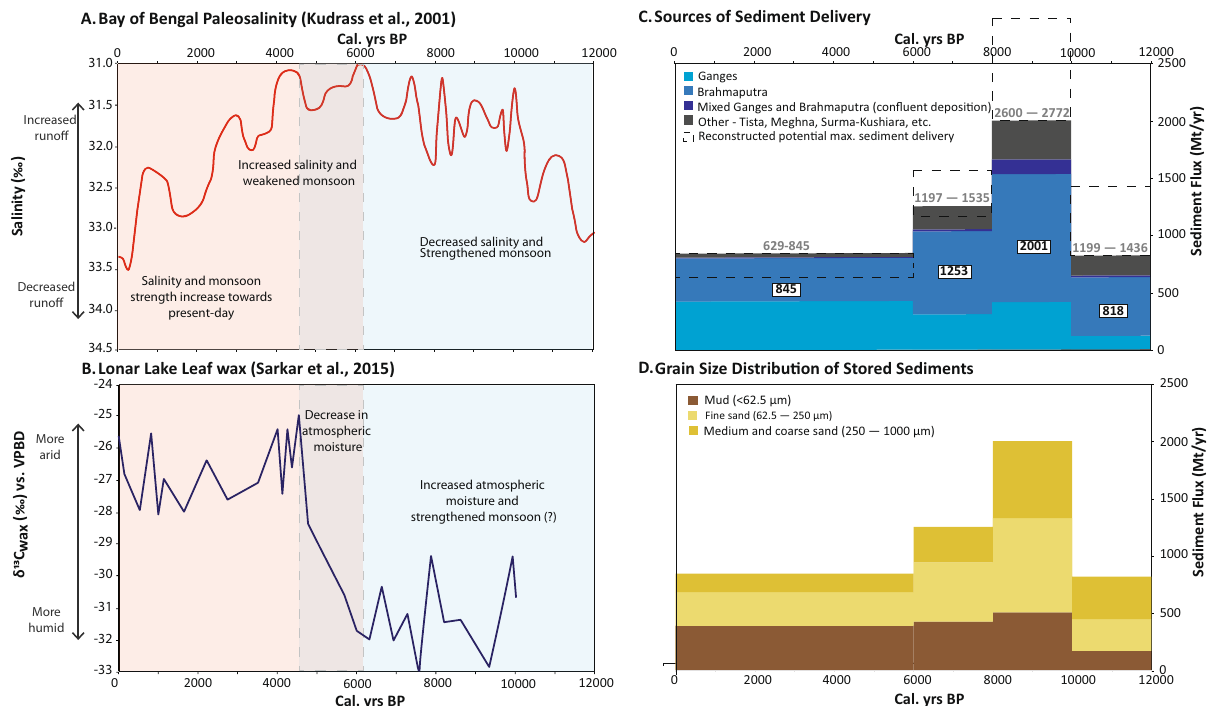
Fig. 2 | Holocene variability in sediment mass and caliber corresponds with changes in paleosalinity and atmospheric moisture as proxies for freshwater discharge and monsoon precipitation, respectively. A A paleosalinity record from sediment cores collected in the northern Bay of Bengal 26 provides a proxy record foranenhanced early Holocene monsoon, when runoffand river discharge increased and lowered salinity of the surface mixed layer. Salinities decrease after 6 ka under weakening monsoon precipitation and reduced (but still large) river discharge. B Terrestrial records of leaf-wax stable carbon isotopes from lacustrine sediments in Lonar Lake, central India 25 provide evidence for increased atmo- spheric moisture during the Holocene Climatic Optimum (~9 – 5 ka), with sharply